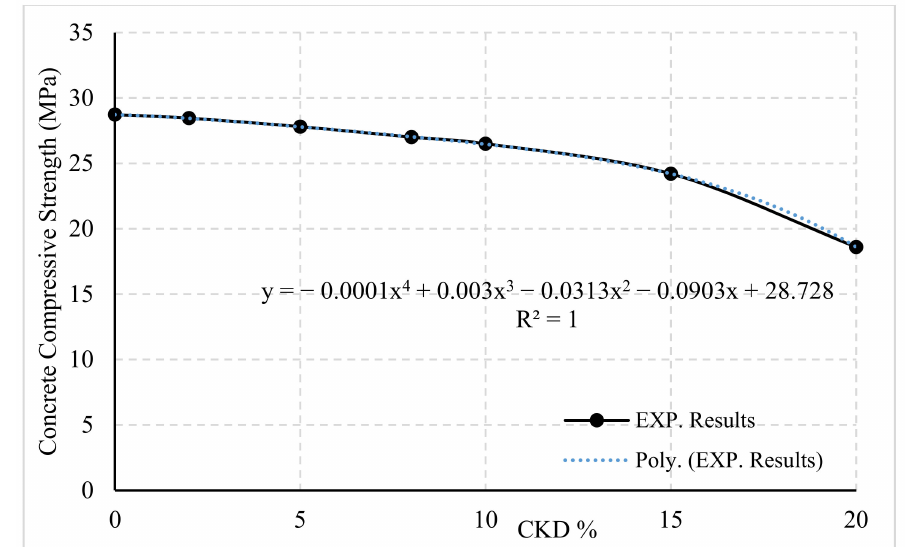
Figure 2. Compressive strength versus percentage of CKD.